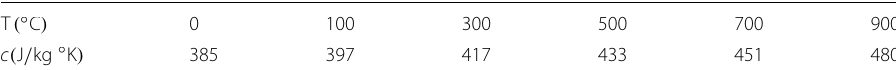
Table 1 Temperature dependent specific heat of pure copper [61] T ( ◦ C )